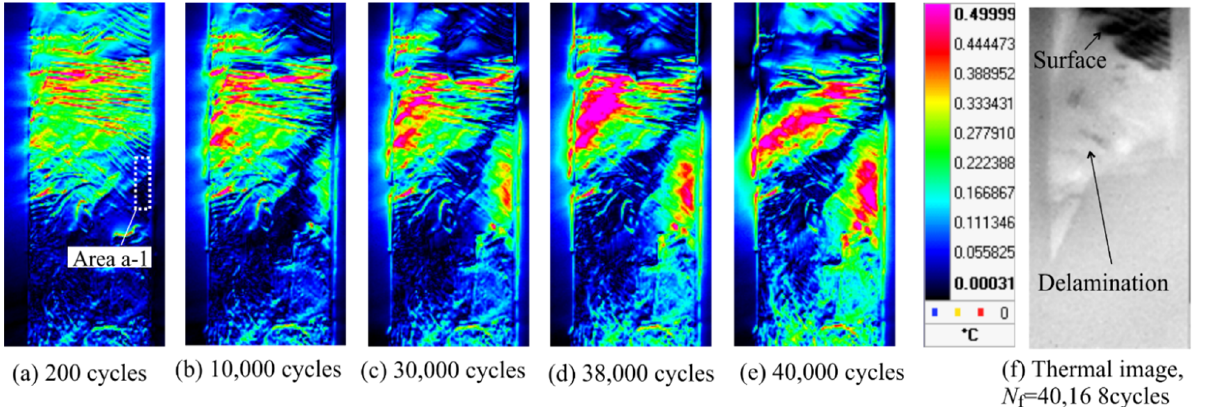
Figure 3. Change in the distribution of thermoelastic temperature change. Table 1. Specifications and setting of employed infrared camera.